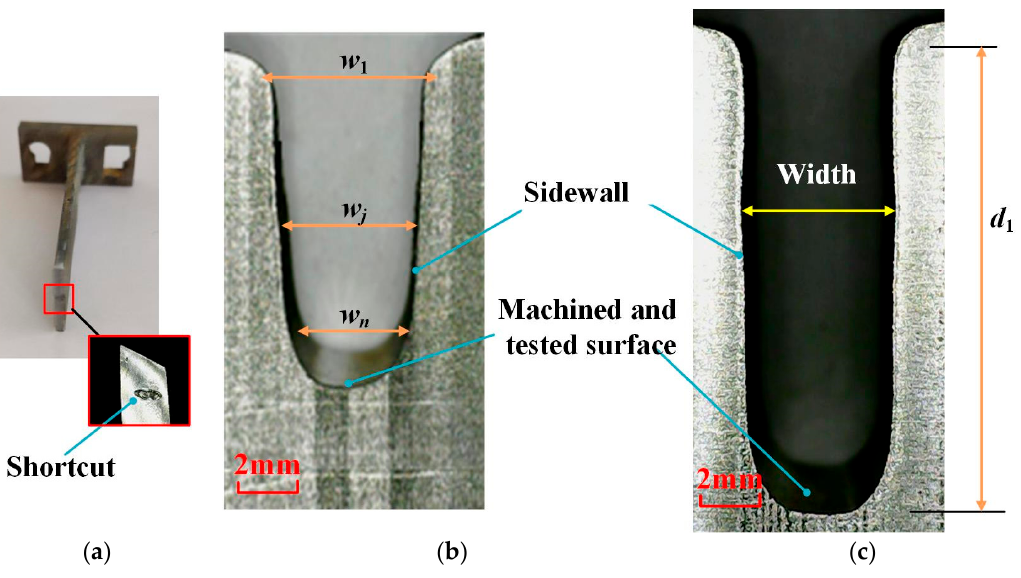
Figure 14. Morphology of blisk channels under different feed modes; ( a ) shortcut region of the cath- ode; ( b ) workpiece obtained in contrast experiment; ( c ) workpiece obtained by the vibration-assisted channel